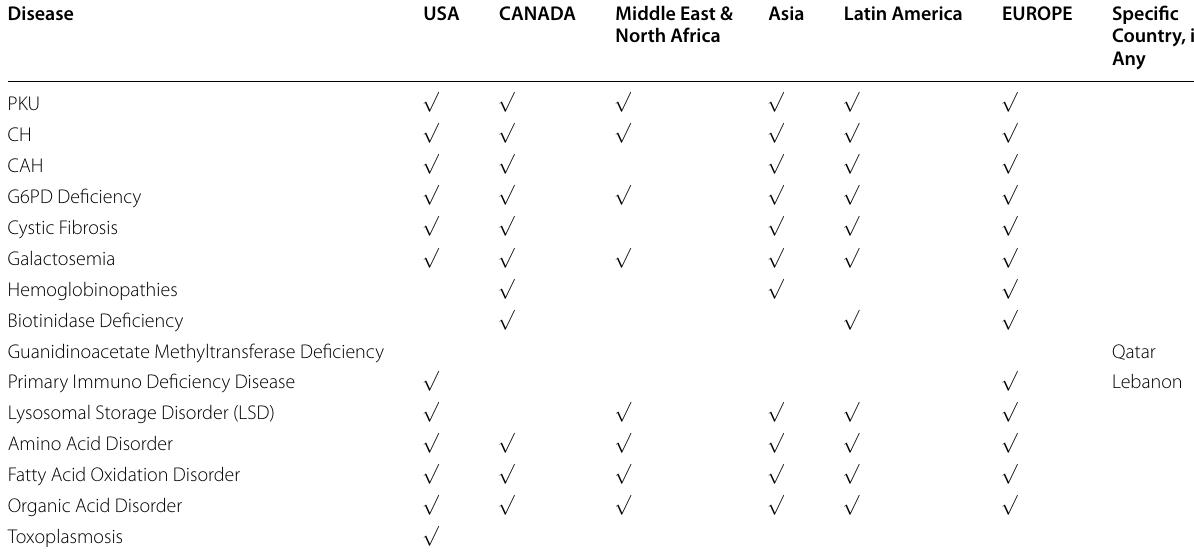
Table 4 Main diseases being covered by New Born Screening (NBS) programs in different regions of world. Following the Wilson- Jungner criteria CH, PKU, Galactosemia, amino acid disorders, Fatty acid oxidation disorders and organic acid disorders are almost being screened